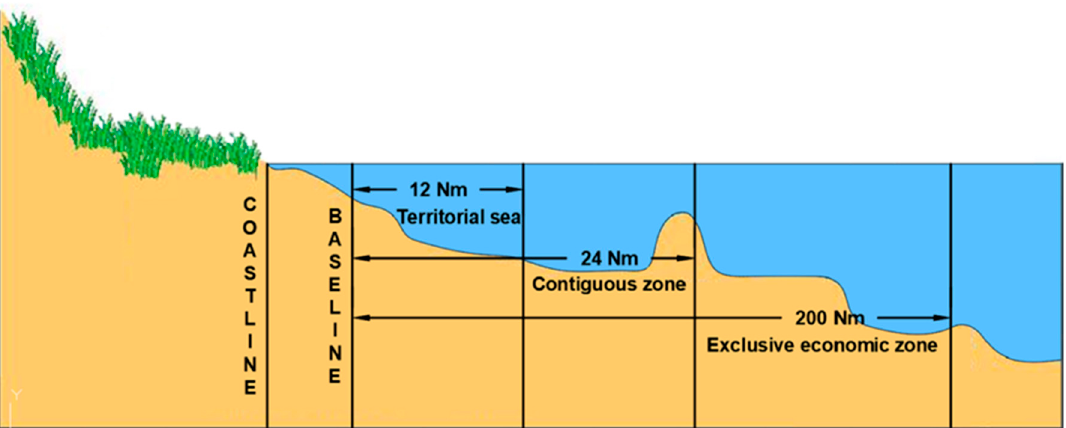
ff ect of the baseline to the outer limits of maritime zones. Own study based on: Figure 1. The effect of the baseline to the outer limits of maritime zones. Own study based on: [6]. Figure 1. The e